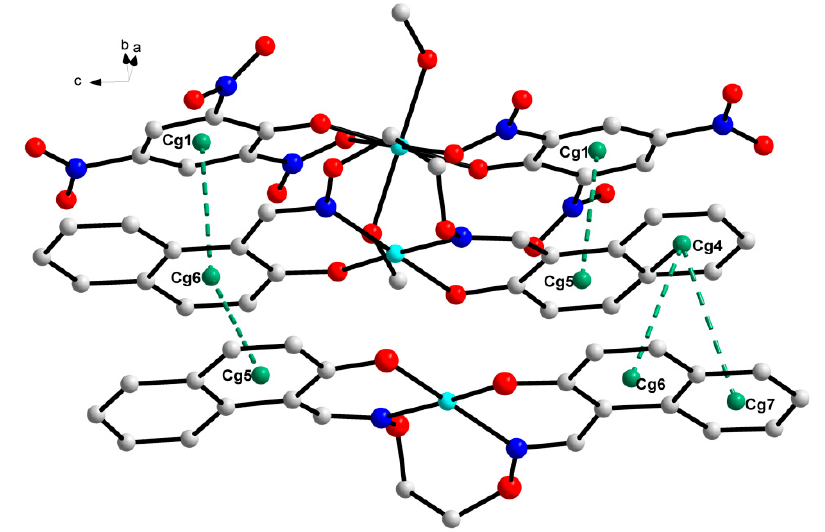
Figure 7. View of supramolecular structure of complex 1 showing the formation five π ··· π stacking interaction. Crystals 2017 , 7 , 247